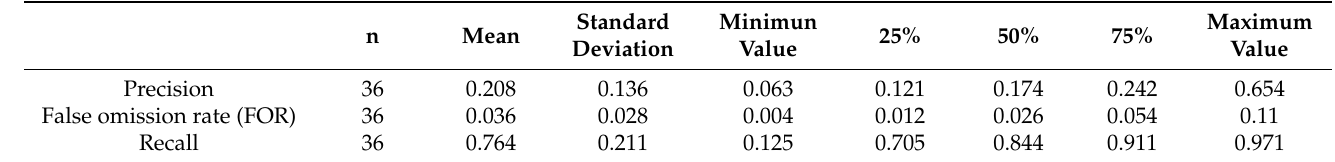
Table 2. Summary of statistics describing the performance of the neural network model applied to the fishery of anchovy ( E. ringens ) in Northern Chile, considering the 36 days of the greatest catch in the entire series chosen as a study